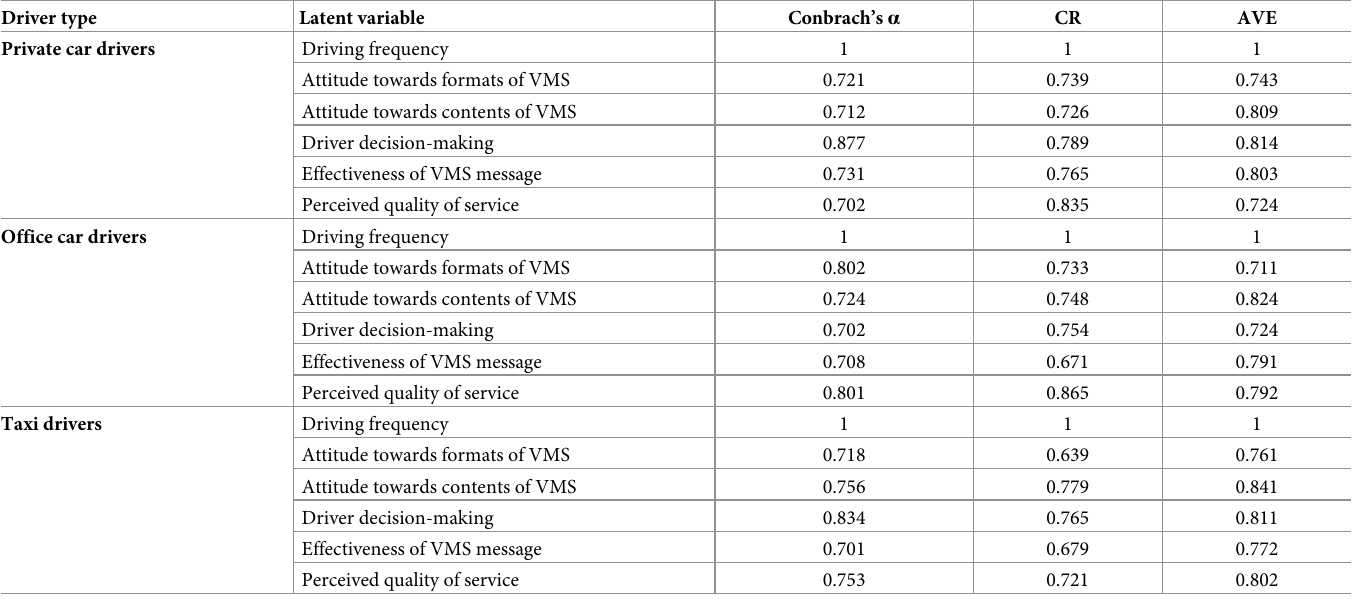
Table 4. Results of